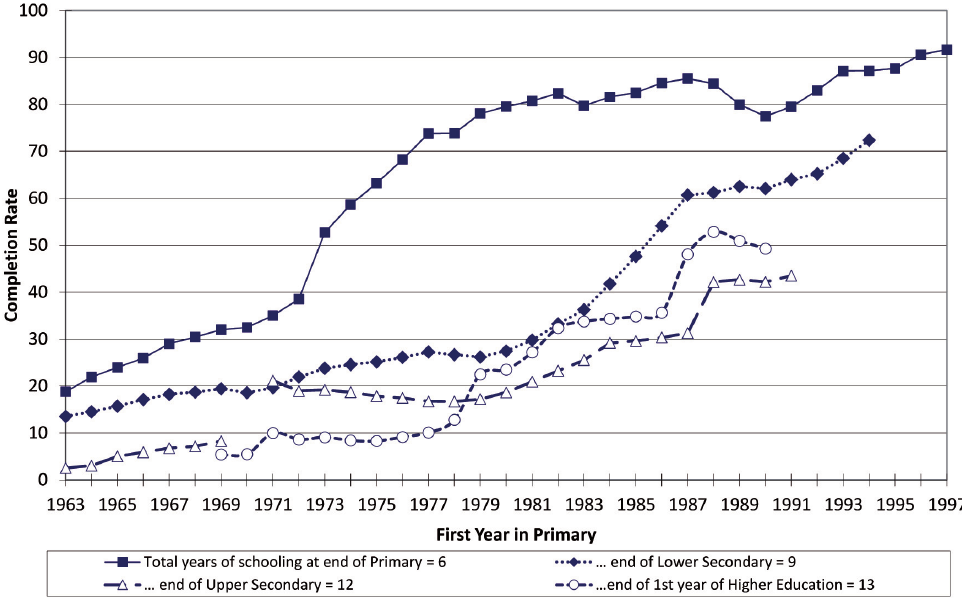
Figure 2: Rates of completion by education level and full generation of entrants into primary